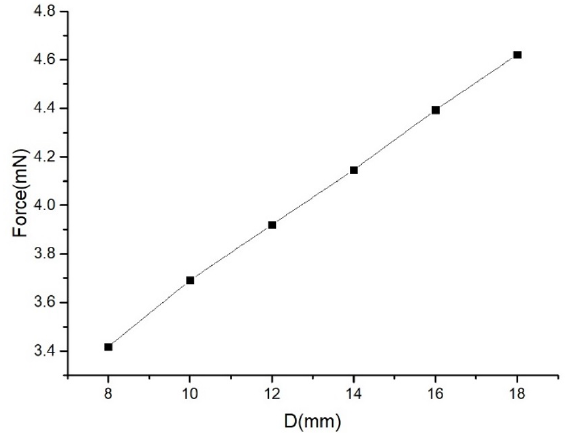
Fig. 12. Influence of shaft core diameter on stress of shaft